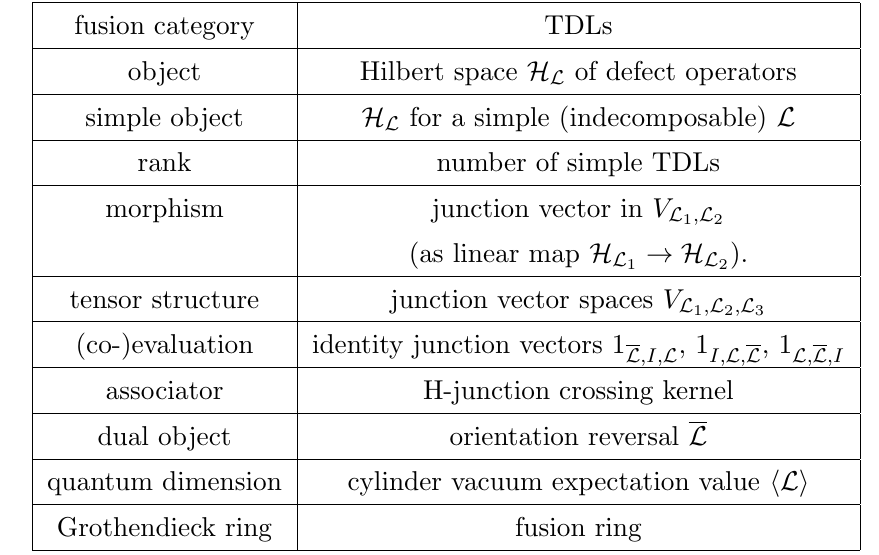
Table 1 . Summary of the relations between fusion category and